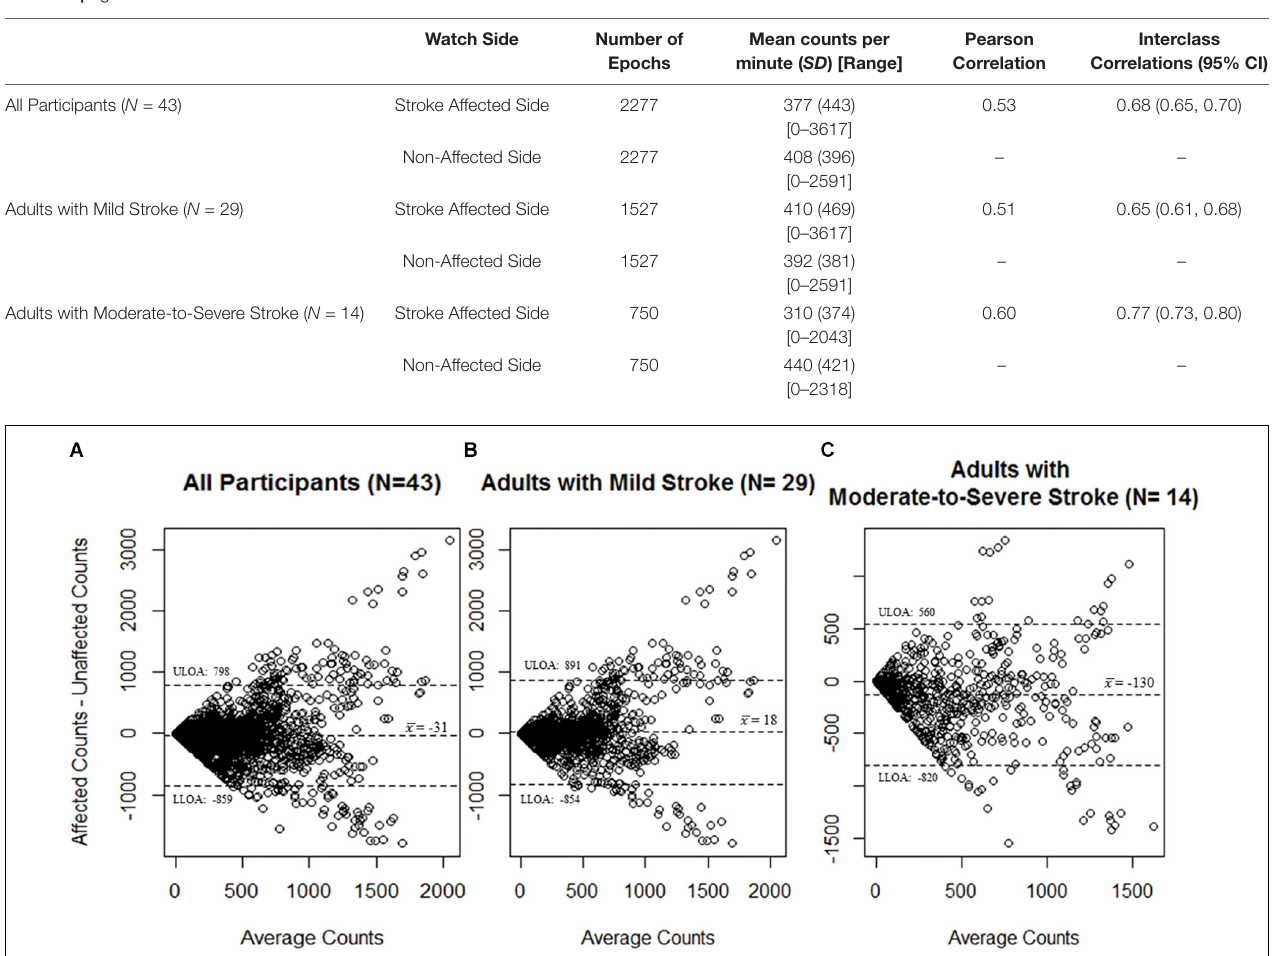
FIGURE 1 | Bland–Altman plots for agreement of the MotionWatch8 for (A) all participants ( N = 43); (B) participants with mild stroke ( N = 29); and (C) participants with moderate-to-severe stroke ( N = 14). Differences between counts reported by the stroke affected side MW8 and the stroke non-affected side MW8 are reported. A greater amount of activity was associated with less agreement between the affected side MW8 and non-affected side MW8, irrespective of stroke severity. Dotted lines represent upper and lower limits of agreement. ULOA: Upper Limit of Agreement; LLOA: Lower Limit of Agreement.